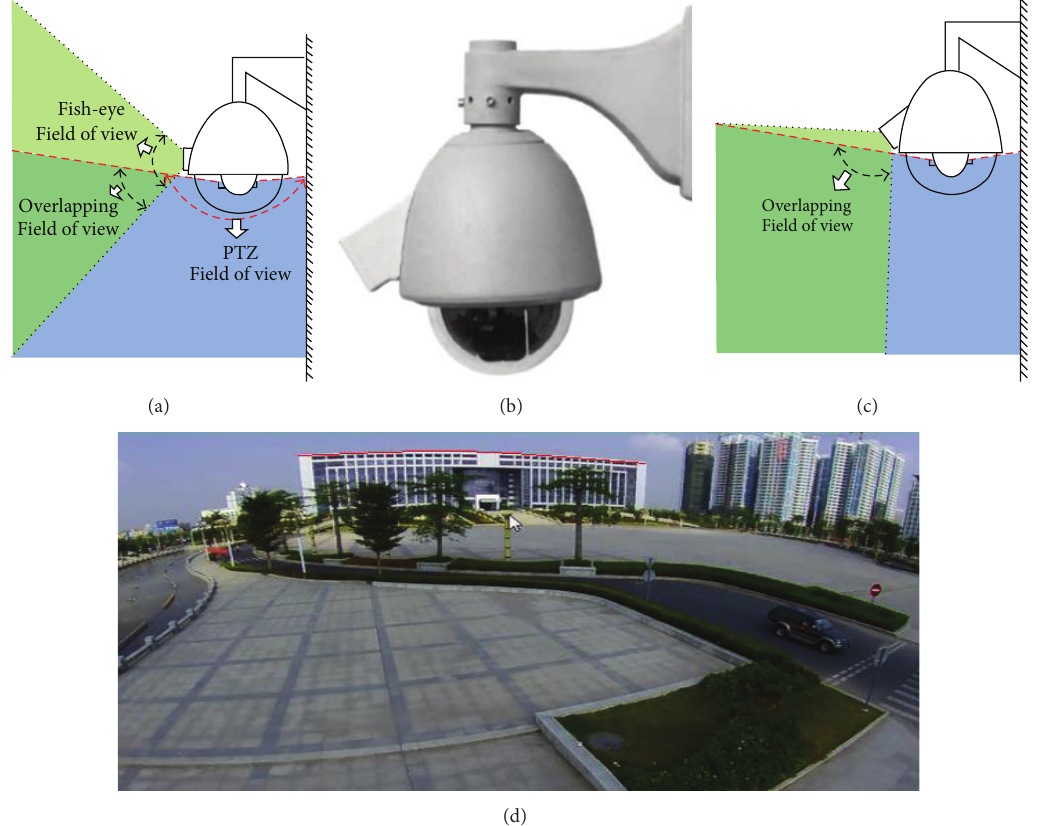
Figure 3: (a) If the fish-eye camera is mounted parallel to front, two cameras only have small overlapping FOV (b) The side view of master- slave visual surveillance system (c) The inclining angle ensures that the PTZ dome camera covers the FOV of fish-eye camera. (d) Image distortion appeared on the panoramic camera marked by the red curve